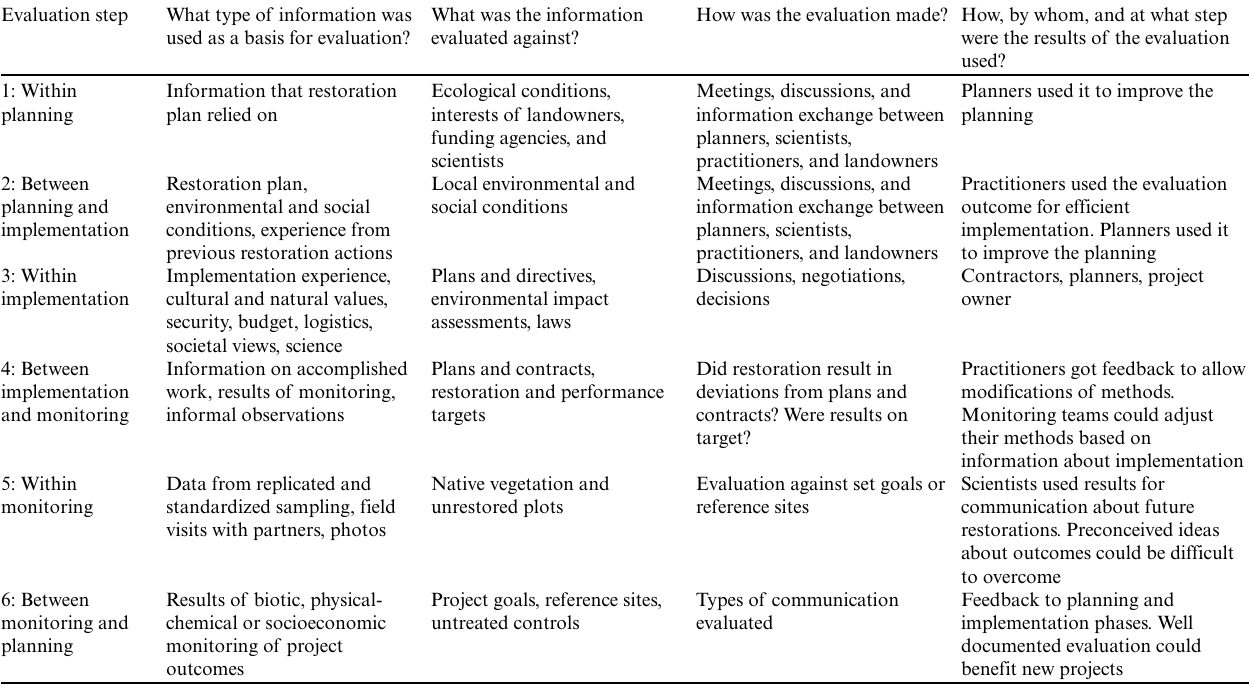
Table 1 . Summary of the information used for evaluation, how the evaluation was made, and by whom in the six evaluation steps (Figs. 1 and